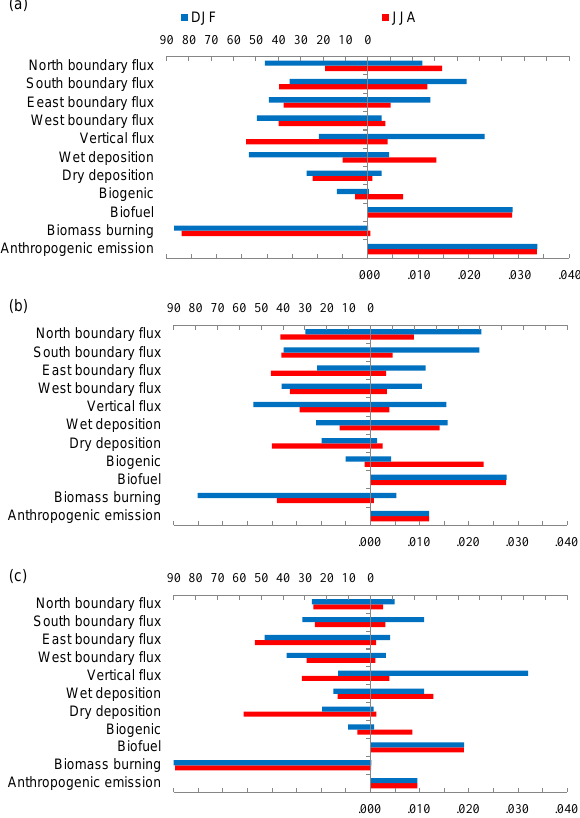
Figure 13. Organic carbon budget (mass flux from each process in TgCseason − 1 , right) and APDM of each flux (%, left) in (a) NC, (b) SC, and (c) SCB obtained from simulation ANNmet. Blue lines are for DJF and red lines are for JJA. Transport fluxes were calcu- lated at the boundaries while other sources and sinks were calcu- lated as the sums over the grid cells of the region under